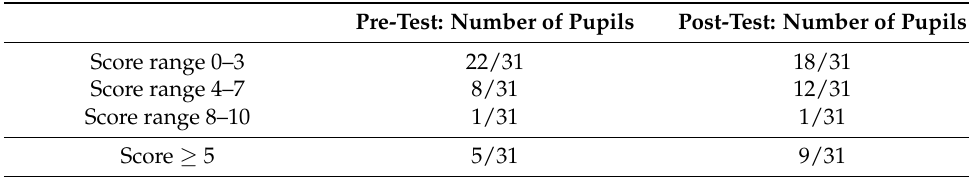
Table 5. Descriptive analysis for the flashcards intervention. Pre-Test: Number of